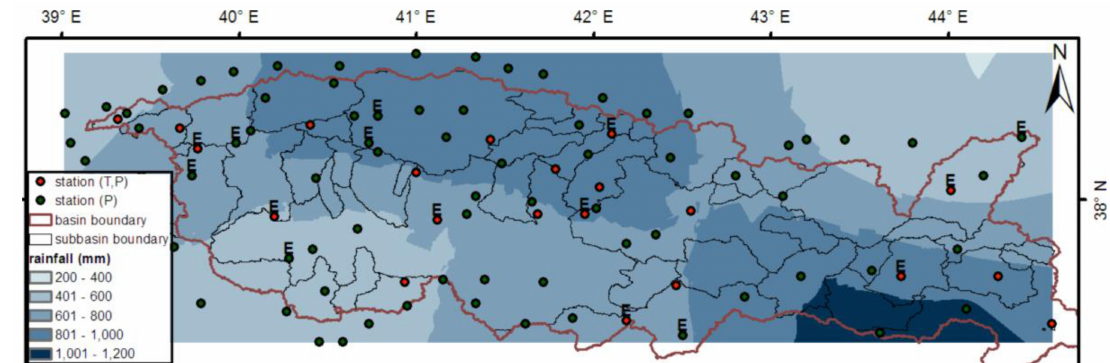
Figure 2. Spatial distribution of the yearly rainfall map using ordinary Kriging method and distribution of meteorological stations including sub-basins of the study area (red circles show stations that measure temperature and precipitation, green circles show stations that measure precipitation, and the abbreviation E shows stations that measure evaporation).